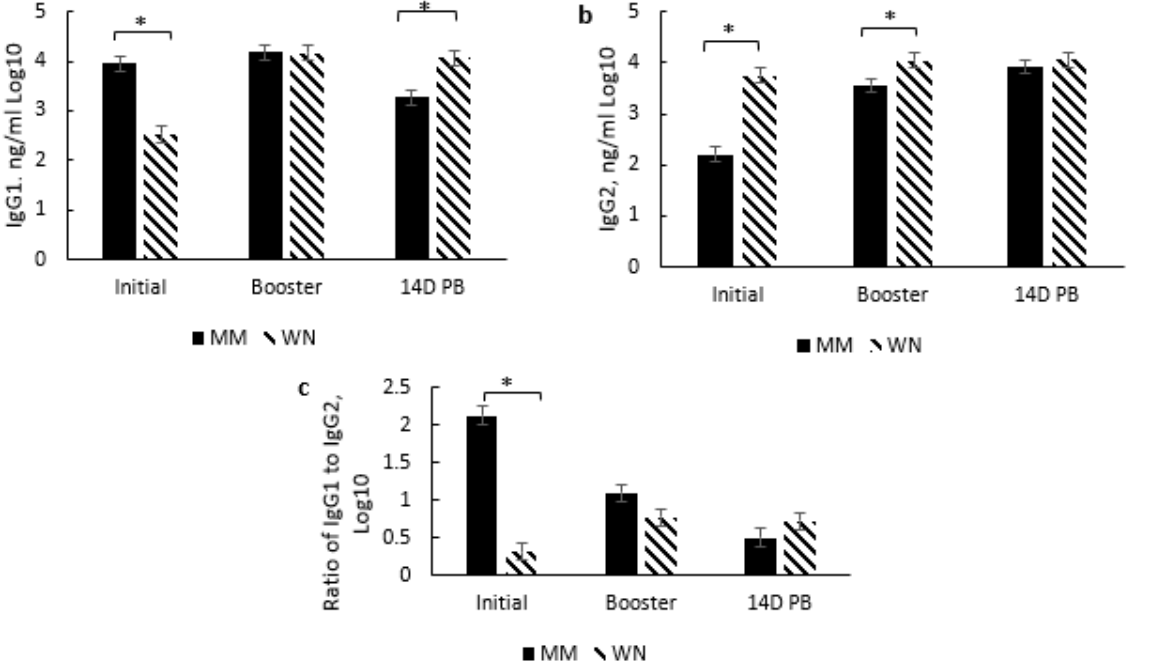
Figure 5. Effect of vaccination timing by day of vaccination on serum concentrations (ng/mL) of immunoglobulin G1 ( a ), immunoglobulin G2 ( b ), and the ratio of immunoglobulin 1 to immunoglobulin 2 ( c ) at initial vaccination, booster vaccination, and 14 days post booster vaccination (14D PB). Data are expressed as means ± standard error of the mean. Means with * between treatments within a day differ at p < 0.05. Treatment × Day = p < 0.0001 for IgG1, p < 0.0001 for IgG2 and p < 0.0001 for IgG1:IgG2.